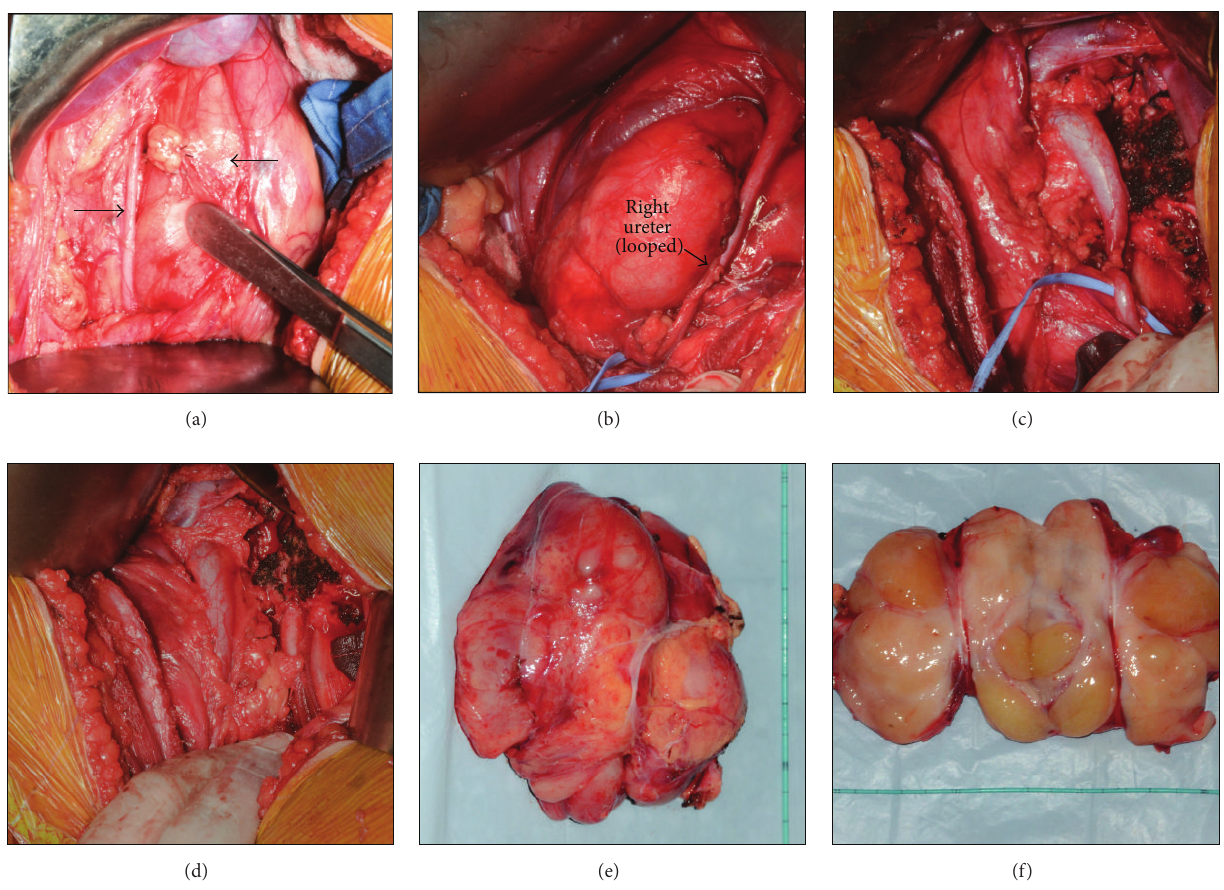
Figure 2: (a) The intraoperative findings: left arrow indicating the retroperitoneal mass; right arrow indicating the ureter. (b) The ureter looped and traced. ((c), (d)) Tumor excised and base fulgurated. (e) The resected tumor. (f) Cut section of the